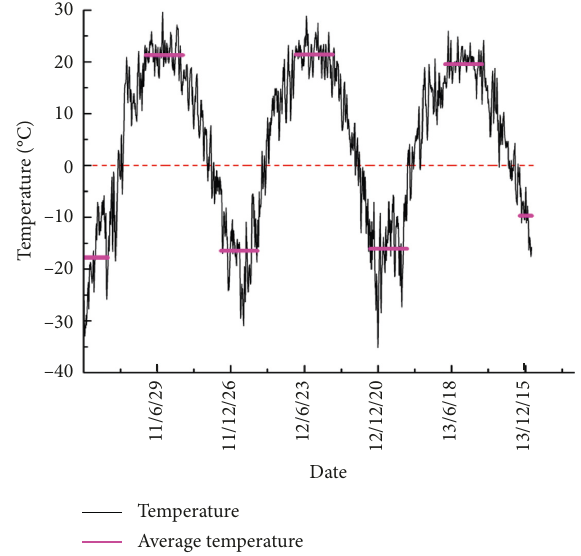
Figure 4: The temperature variation in Altai of Xinjiang from 2011 to